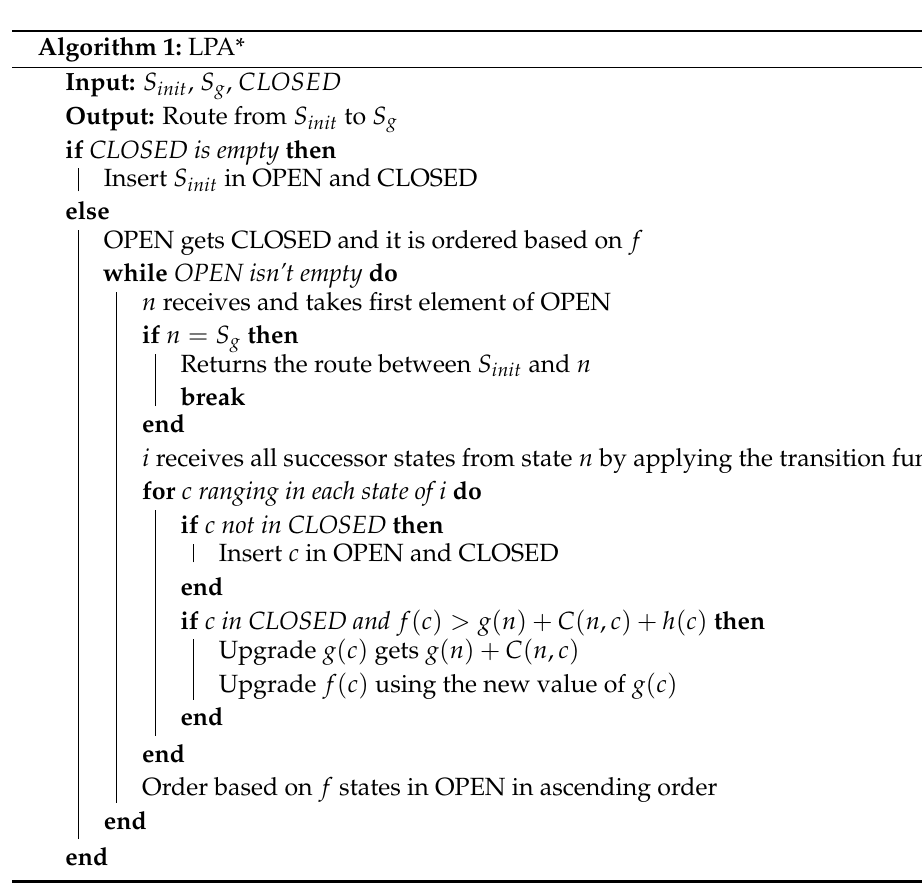
indicates what each value of the map and graph means, which is represented in